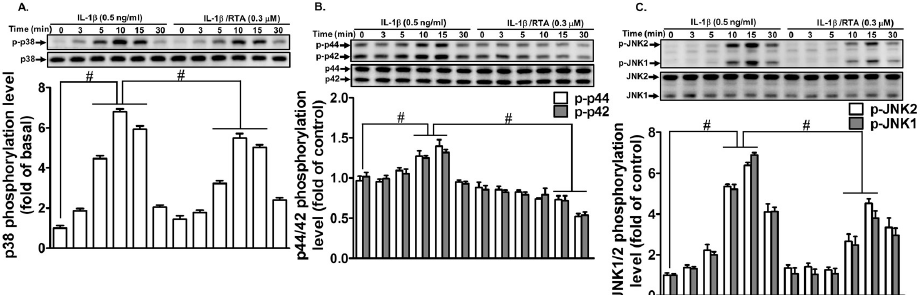
Figure 4. RTA 408 attenuates the IL-1β-induced proMMP-9 expression via suppressing MAPKs phosphorylation. Cells were pretreated with RTA 408 (0.3 µM) for 4 h, and then incubated with IL-1β (0.5 ng/mL) for the indicated time intervals (3, 5, 10, 15, and 30 min). The cell lysates were assayed by western blot to detect phosphorylation of p38 MAPK ( A ), p42/p44 MAPK ( B ), and JNK1/2 ( C ) using their respective phosphorylated antibody. Data analysis and processing are described in the section “Statistical Analysis of Data.” # indicates p < 0.01, as compared between the indicated groups. The figure represents one of three individual experiments.